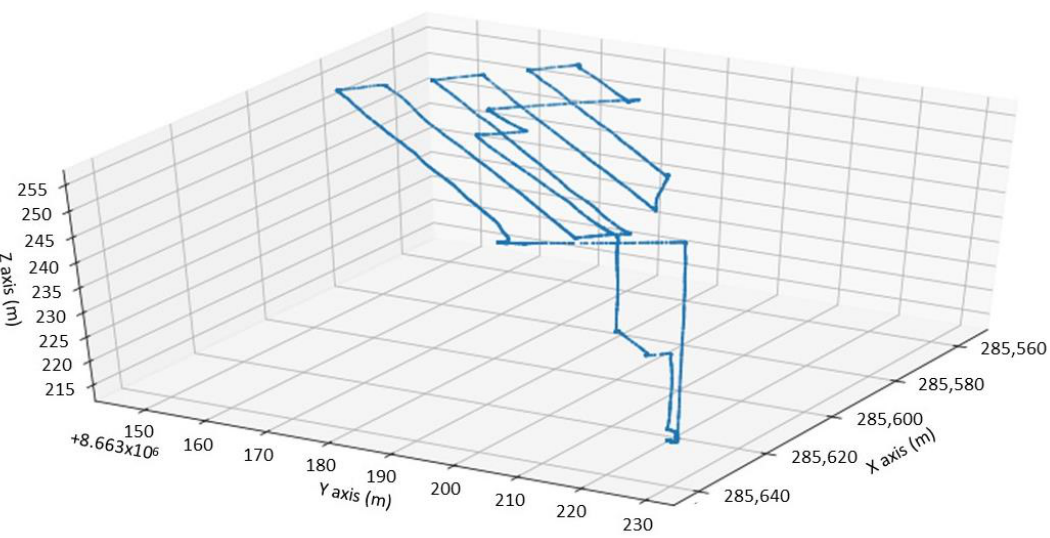
Figure 17. UAV flight path in the UTM reference system. The final point cloud is the result of merging the five different point clouds, through which better point accuracy and density were obtained, as shown in Figure 18.